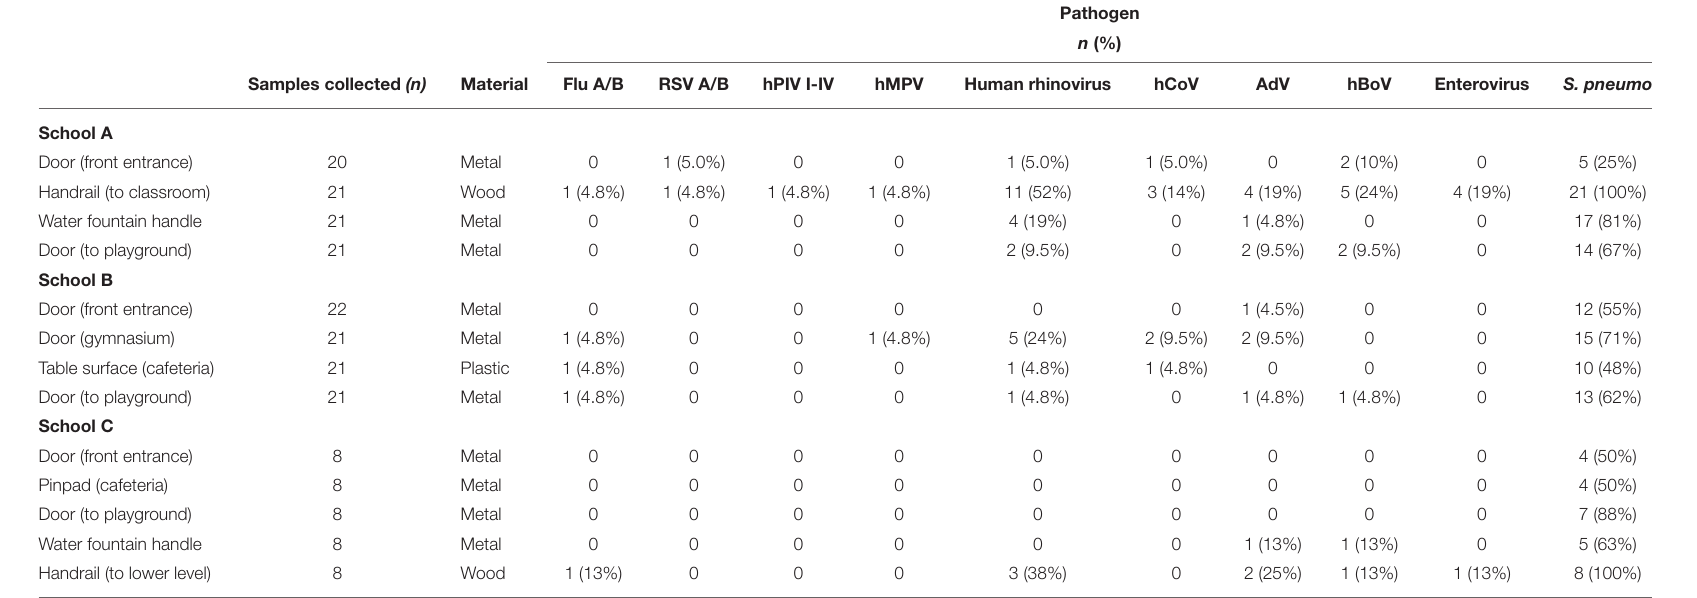
TABLE 1 | Sites, surfaces, and pathogens detected between 13 surfaces sampled across three elementary schools in Seattle,